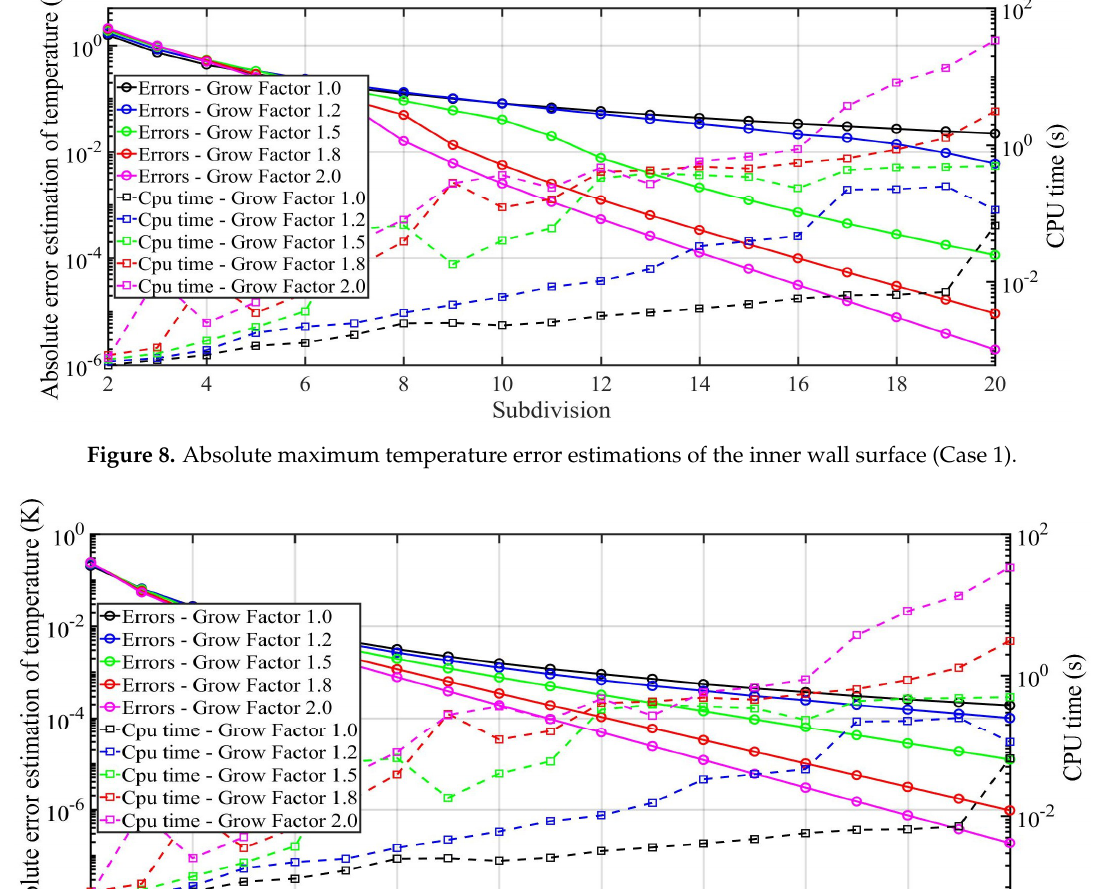
Figure 10. Relative maximum temperature error estimations of the inner surface (Case 1). Figure 11. Relative maximum temperature error estimations of the outer surface (Case 1). The errors in the second case for lower subdivisions are equivalent to errors in the first case for high subdivisions. This is because the inertia of the thin wall is not significant. The relative errors of the inner and outer walls are almost the same (Figures 13,14).